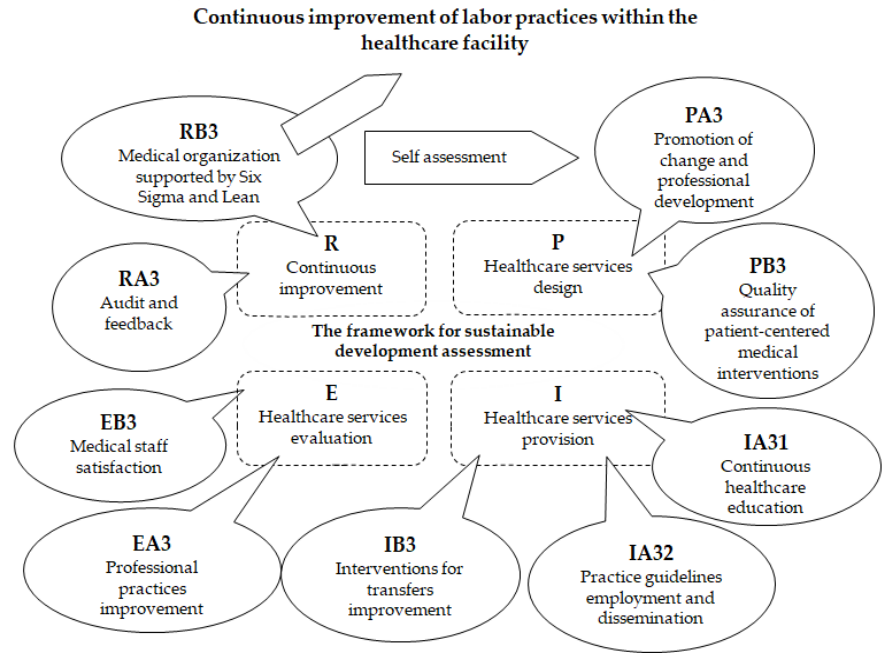
Figure 3. Thelabor practices continuous improvement cycle.